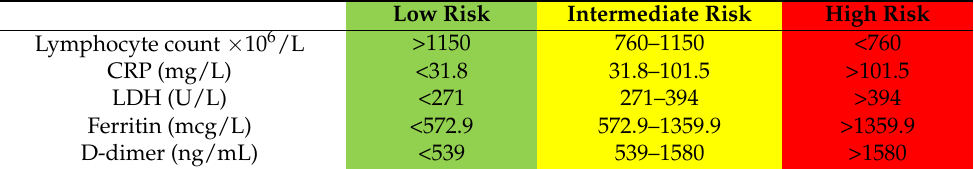
CRP: C-reactive protein. LDH: lactate dehydrogenase. The colors in the table indicate the risk traffic light in 3 categories: low risk (green), intermediate risk (yellow), and high risk (red). Table 2. General data for the three categories.